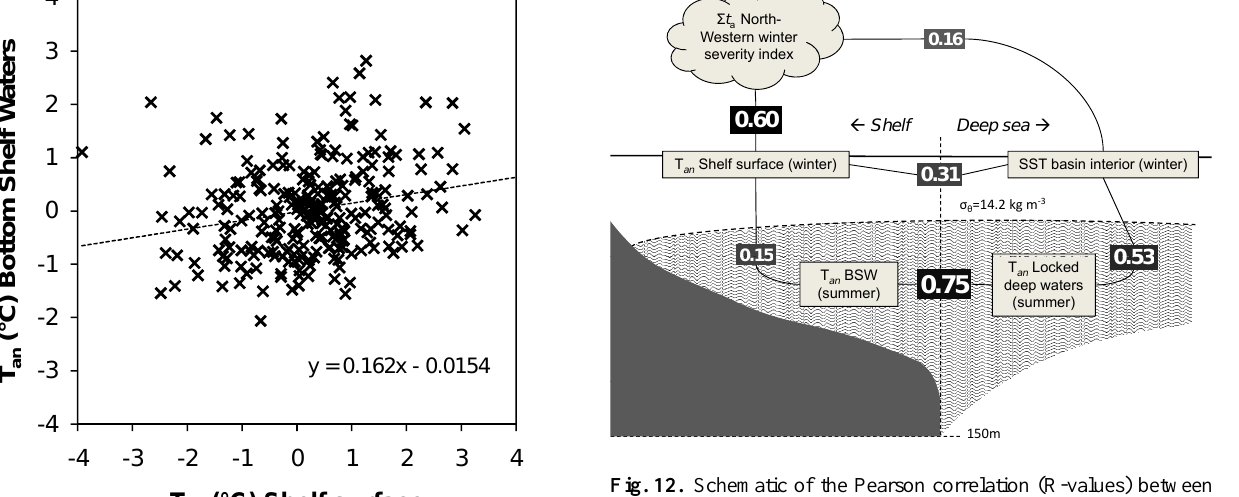
Fig. 12. Schematic of the Pearson correlation (R-values) between various long-term temperature time series over the period 1950– 2005. The shelf limit is the 150m isobath, the locked BSW is bounded by the σ θ = 14 . 2kgm − 3 isopycnal and the